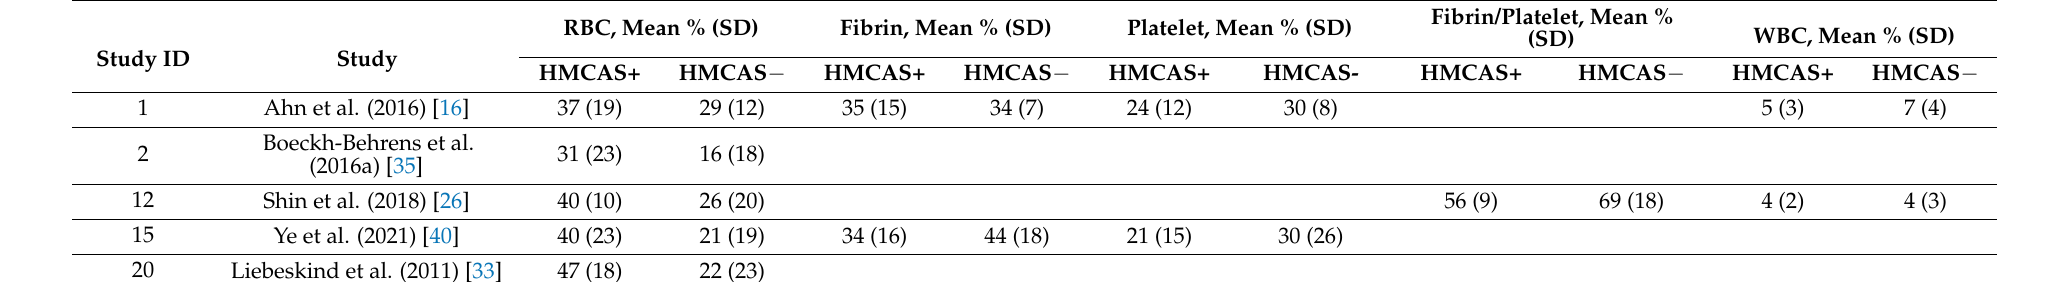
Table 4. Clot Component Fractions and